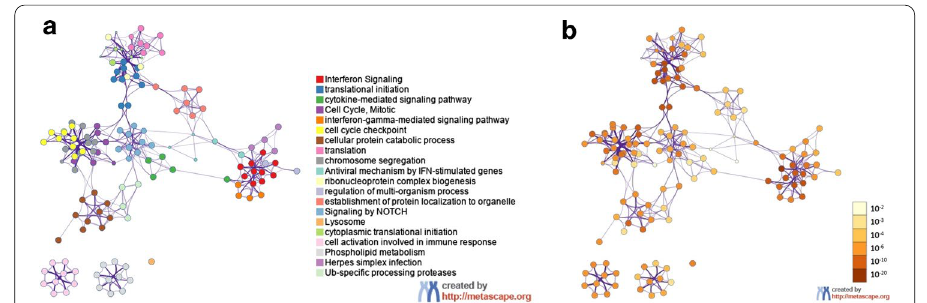
Fig. 2 Metascape functional analysis of transcriptional differences in circulating leukocytes from COVID19 and COVID19 critically ill patients. The list of 1311 differentially expressed genes was submitted + − to Metascape using express analysis of Homo sapiens gene IDs. A subset of enriched terms was selected and rendered as a network plot, where terms with a similarity > 0.3 were connected by edges. The network was visualized using Metascape. Each node represents an enriched term and coloured first by its cluster ID ( a ) and then by its p -value ( b )